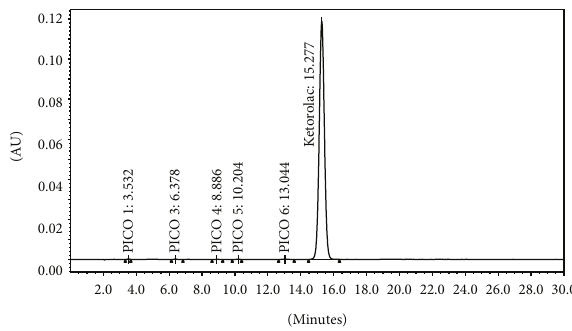
Figure 4: Chromatogram for the photolytic degradation of ketorolac and its degradation products.